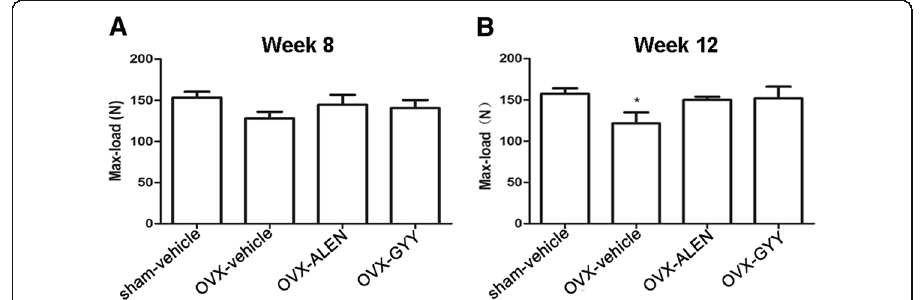
Fig. 5 The results of the biomechanical maximum load experiment. a The OVX model in week 8. b The OVX model in the week 12. The results for the OVX-vehicle group were compared with those for the sham-vehicle group ( p <0.05) and OVX-GYY group ( p <0.05). * p <0.05 vs. sham-vehicle group. OVX-vehicle: ovarectomized rats treated with vehicle; OVX-ALEN: ovarectomized rats treated with alendronate sodium; OVX-GYY: ovarectomized rats treated with